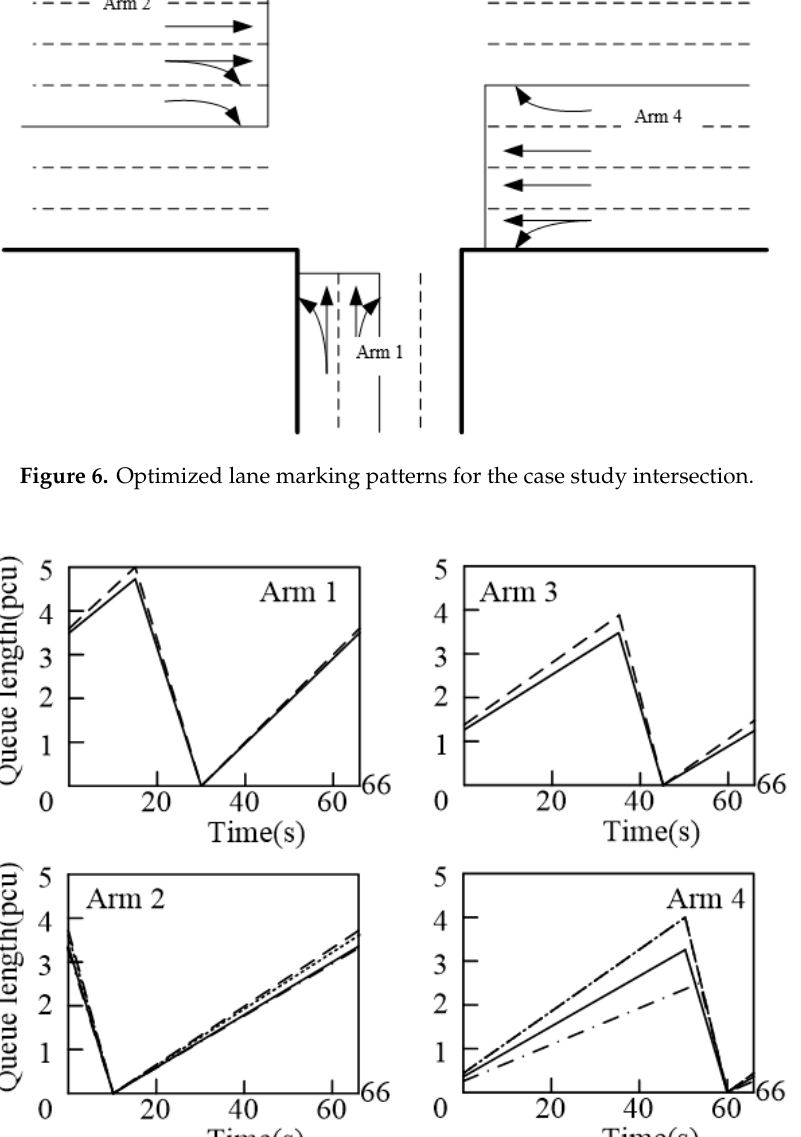
Figure 8. Queue length (in pcu) against time (from start to end of a signal cycle in seconds) from the optimized traffic signal settings in off-peak period.